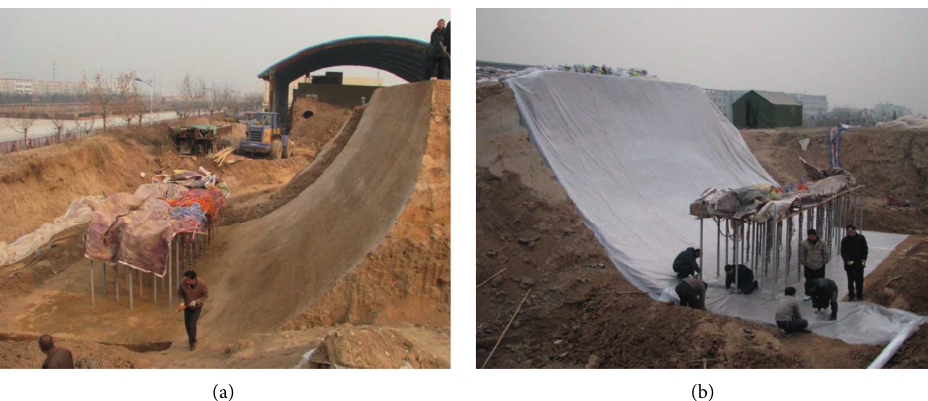
Figure 3: Schematic diagram of sliding surface. (a) The sliding surface; (b) double-layer plastic films were put on the sliding